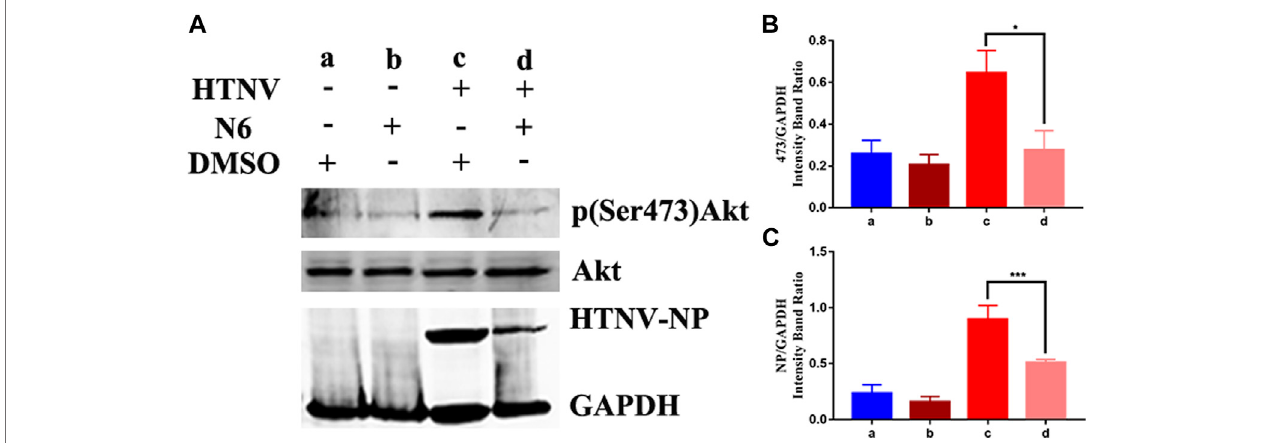
FIGURE 7 | Effect of N6 to the expression of phosphorylated Akt1 (A) The representative Western blot staining for HTNV NP, Akt1, and p (Ser473)Akt proteins in DMSO-treated A549 cells (lane a), N6-treated A549 cells (lane b), HTNV-infected cells (lane c), and N6-treated HTNV cells (lane d) (B) The analyzed result of the expressionofp(Ser473)Akt (C) TheanalyzedresultoftheexpressionofHTNV-NP.Resultsofthestatisticalanalysesaredepictedasfollows:Student ’ sttestorone-way ANOVA; * p < 0.05, ** p < 0.01, *** p < 0.001 vs HTNV, n (cid:2)